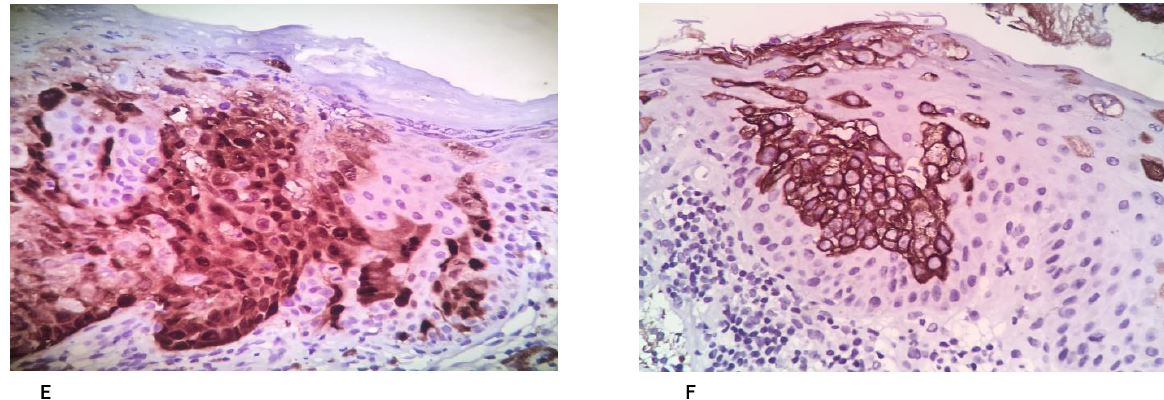
E F Fig. 1. Histopathologic findings of incisional biopsies from the vulvar mass (A, B), Full thickness replacement of epidermis by tumoral squamous cells (VIN3) with neoplastic proliferation of glandular cells in nests pattern (Paget’s disease) (arrows) (100X and 400X, respectively). (C, D) Near to totally replacement of epidermis by neoplastic proliferation of glandular cells (Paget’s disease) (100X and 400X, respectively), (H&E). E: p16 expression in VIN3, X400(IHC). F: CK7 expression in Paget’s disease, X400(IHC). G: CEA expression in Paget’s disease,